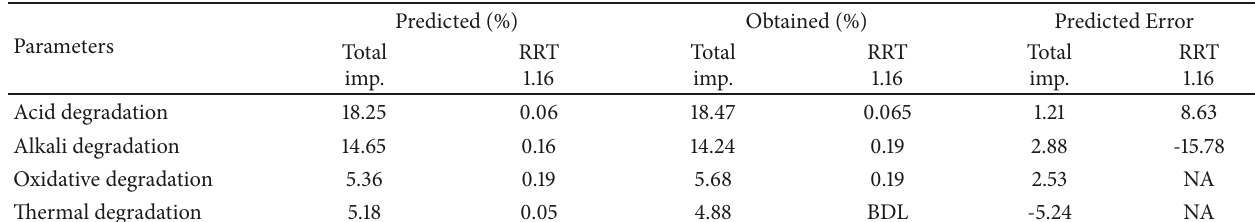
Table 7: Comparison of experimental and predictive values of different responses under optimal conditions. Parameters